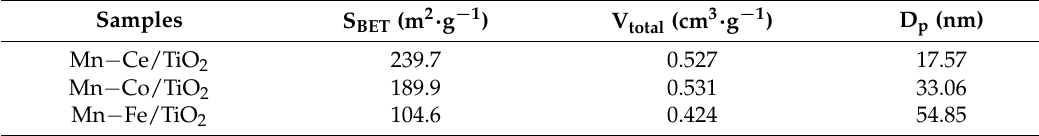
Table 2. Physical properties of Mn-based bimetallic nanocatalysts. 256